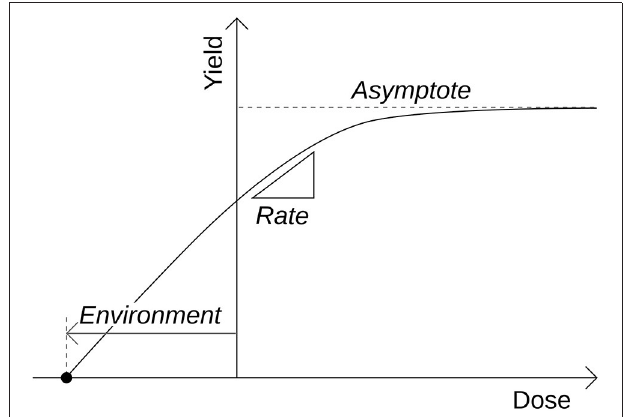
FIGURE 1 | Scheme of the Mitscherlich parameters.